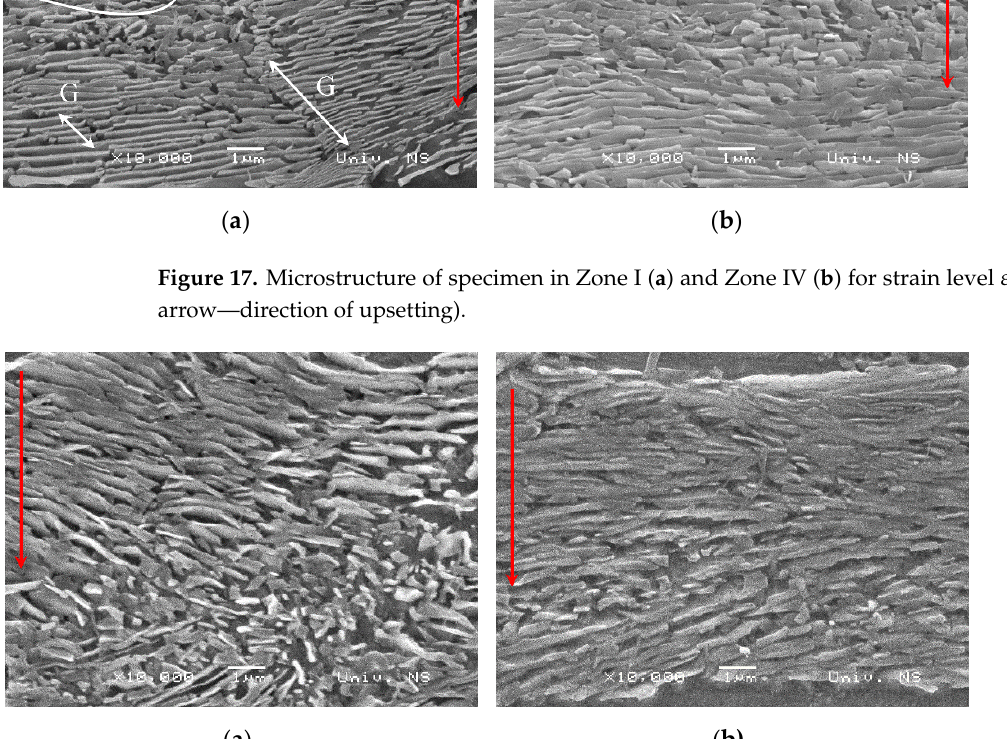
Figure 18. Microstructure of specimen in Zone I ( a ) and Zone IV ( b ) for strain level ε z 4 = 1.59 (red arrow—direction of upsetting).